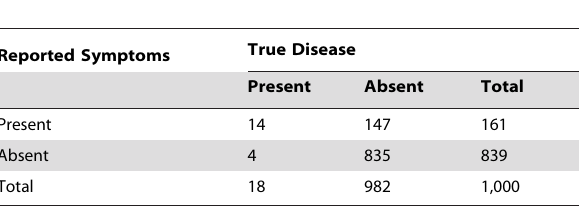
Table 2. Distribution of cases of ‘‘true pneumonia’’ according to caregiver report of ‘‘suspected pneumonia’’ (test) and true disease status when test sensitivity is 80% and specificity is 85%.